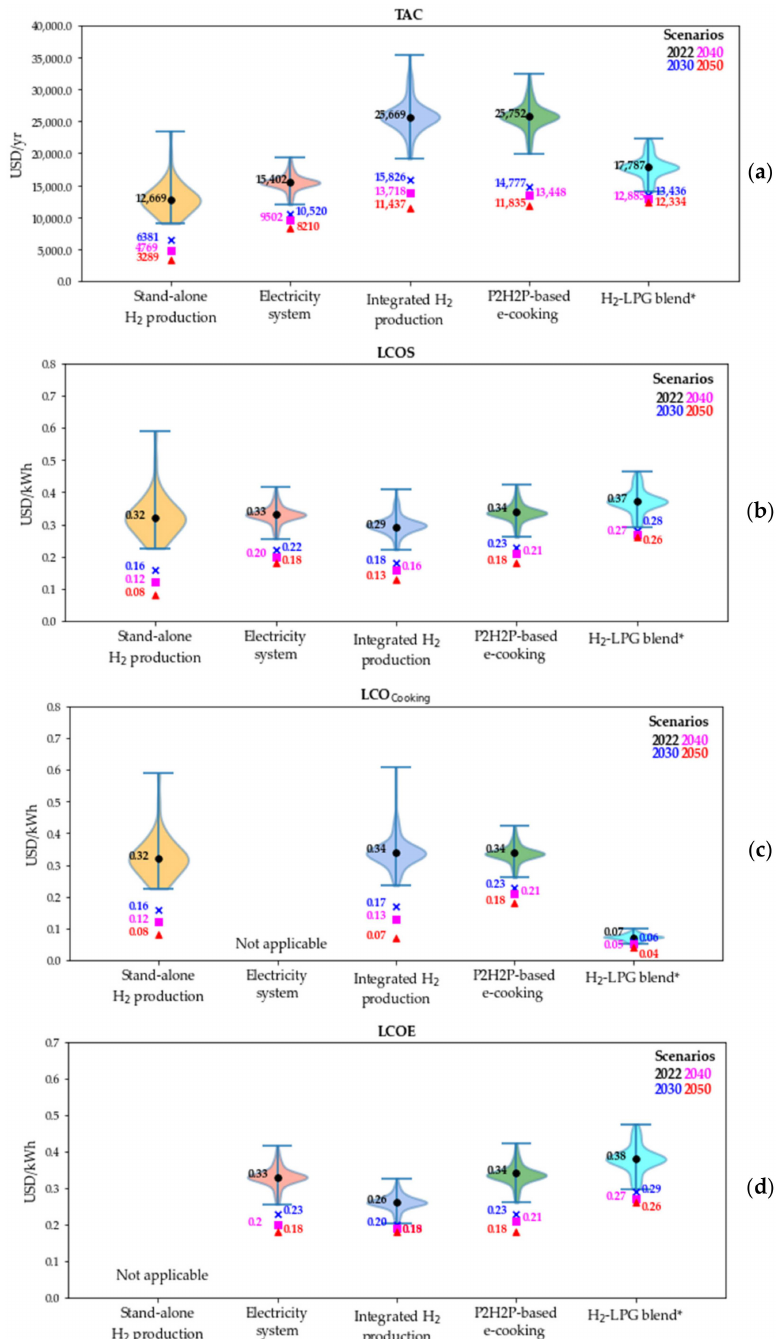
Figure 2. Economic measures of results (( a ) TAC, ( b ) LCOS, ( c ) LCO Cooking , ( d ) LCOE) of the respective energy system topology for parameter constellation assumed in 2022, 2030, 2040, and 2050. The body of the violine plot and its extrema show the space of solutions for when varying PV CAPEX, EL CAPEX, FC CAPEX, battery CAPEX, hydrogen storage CAPEX, WACC, EL efficiency and FC efficiency ± 50% compared to the reference case of 2022 (absolute). Potential increases in the LCOE (e.g., in the integrated hydrogen combustion system) are explained by assumed increases in the efficiency of the electrolysis, decreasing the energy flow via the EL, and thereby, the relative share of PV investment costs accounted for the cooking service system (see Economic Energy System Evaluation). * Note that the H 2 –LPG blending scenario only partly satisfies the cooking energy demand; see Cooking